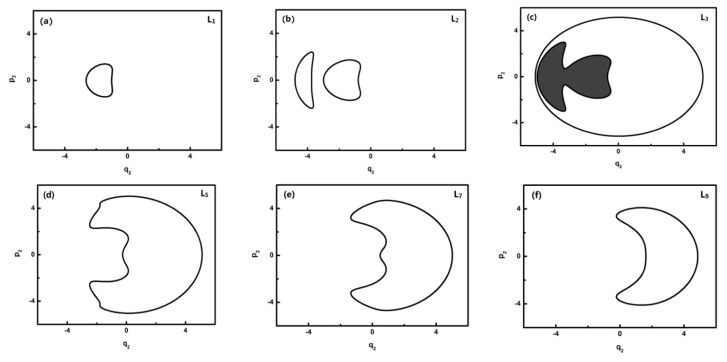
The trajectories of phase space of L1, L2, L3, L5, L7, L9 (q2 coordinates).